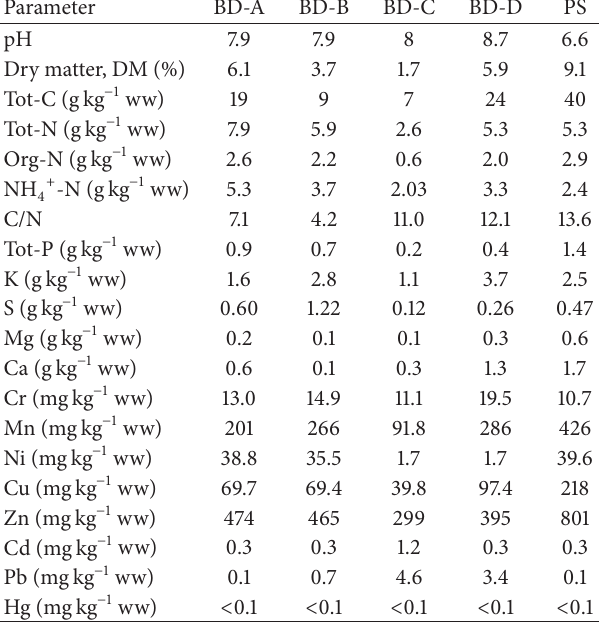
Table 3: Chemical and physical characteristics of the four different biogas digestates (BD-A, BD-B, BD-C, and BD-D) and pig slurry (PS) used in the